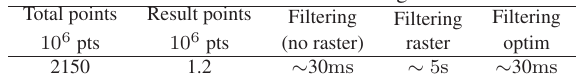
Table 7: Result of pedestrian crossing detection.